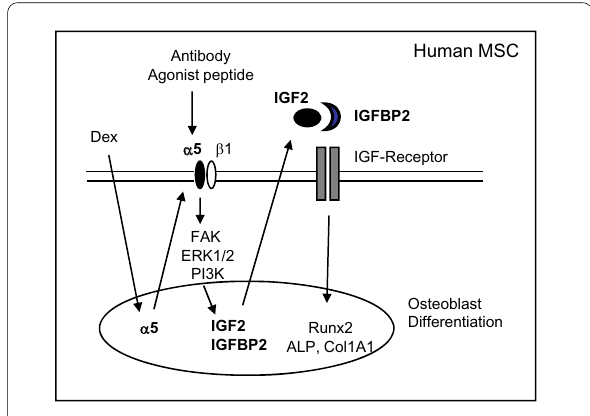
Figure 6 Proposed Model by which Crosstalks Between ITGA5 and IGF2/IGFBP2 Signalling Trigger Osteogenic Differentiation in Human MSCs . ITGA5 expression induced by dexamethasone or ITGA5 activation by agonists upregulate signalling pathways that activate IGF2/IGFBP2 expression in hMSCs which in turn triggers osteoblast dif- ferentiation, revealing that ITGA5 and IGF2/IGFBP2 crosstalks are im- portant mechanisms controlling osteogenic differentiation in human bone marrow derived mesenchymal stromal